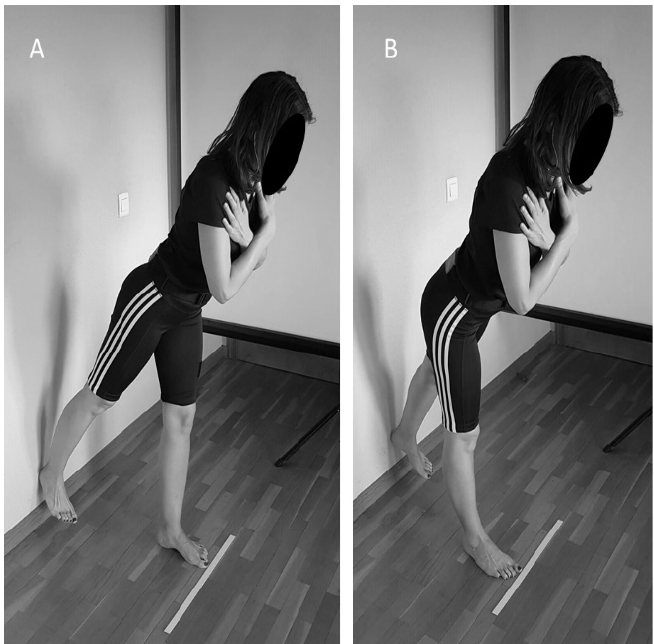
Figure 2. Partial range single leg deadlift test with the right heel ( A ) and the left heel ( B ) touching the wall.